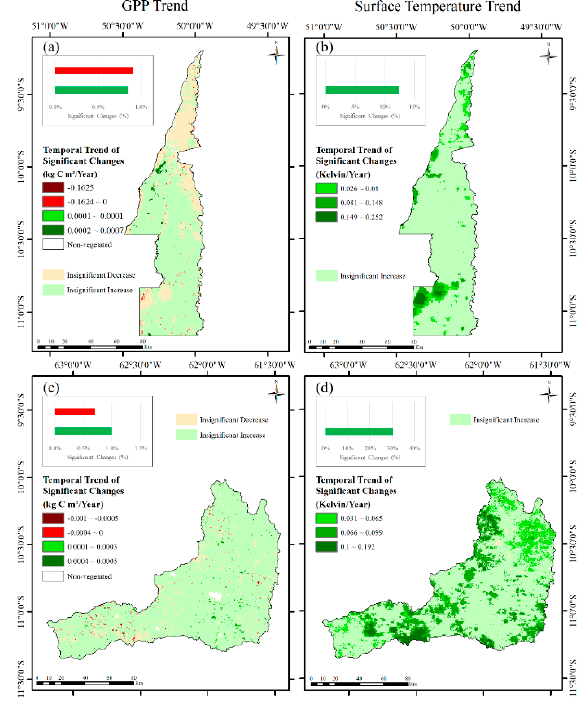
Figure 8. Spatial distribution of the trend per pixel in the period 2001–2016 for: ( a ) Gross Primary Productivity (GPP) in the Ji-Paraná River Basin (JPRB), ( b ) surface temperature in the JPRB ( c ) GPP in the Araguaia National Park and Cantão State Park (ANP-CSP), and ( d ) surface temperature in the ANP-CSP.